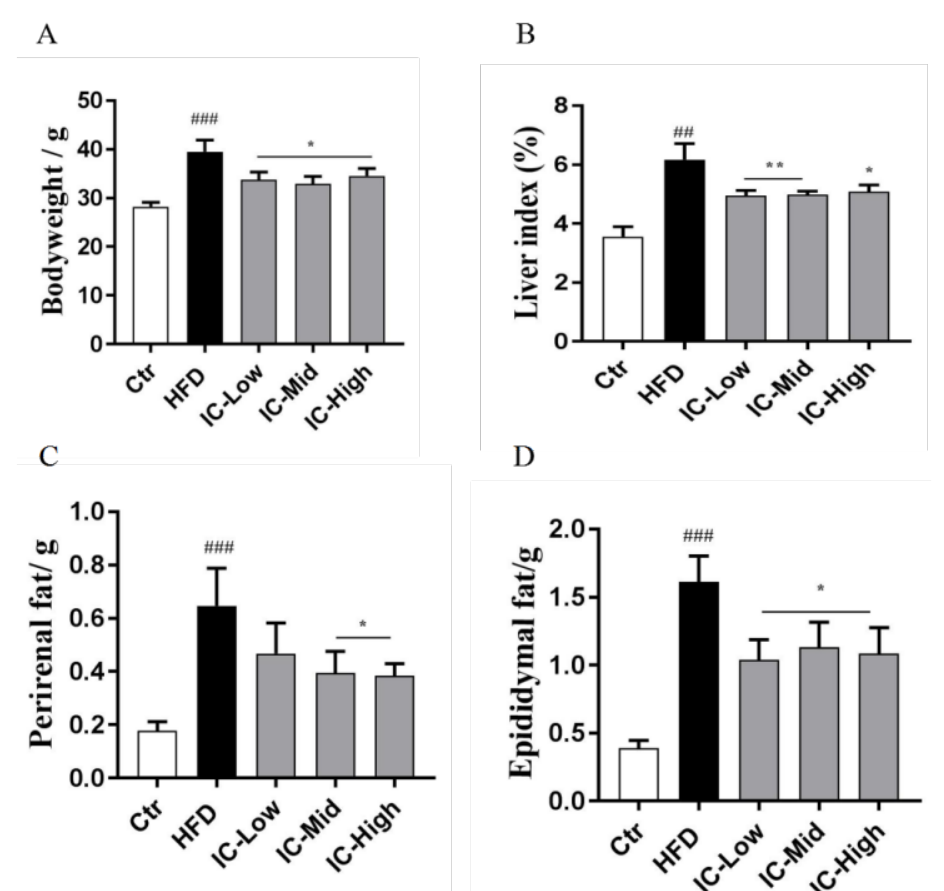
Figure 1. Effects of IC extract on body weight ( A ), liver index ( B ), perirenal fat ( C ), and epididymal fat ( D ). The data represent means ± SEM ( n = 6). ## p < 0.01 and ### p < 0.001 versus the control group; * p < 0.05 and ** p < 0.01 versus the HFD group, respectively. Liver index = (liver weight/body weight) × 100%.